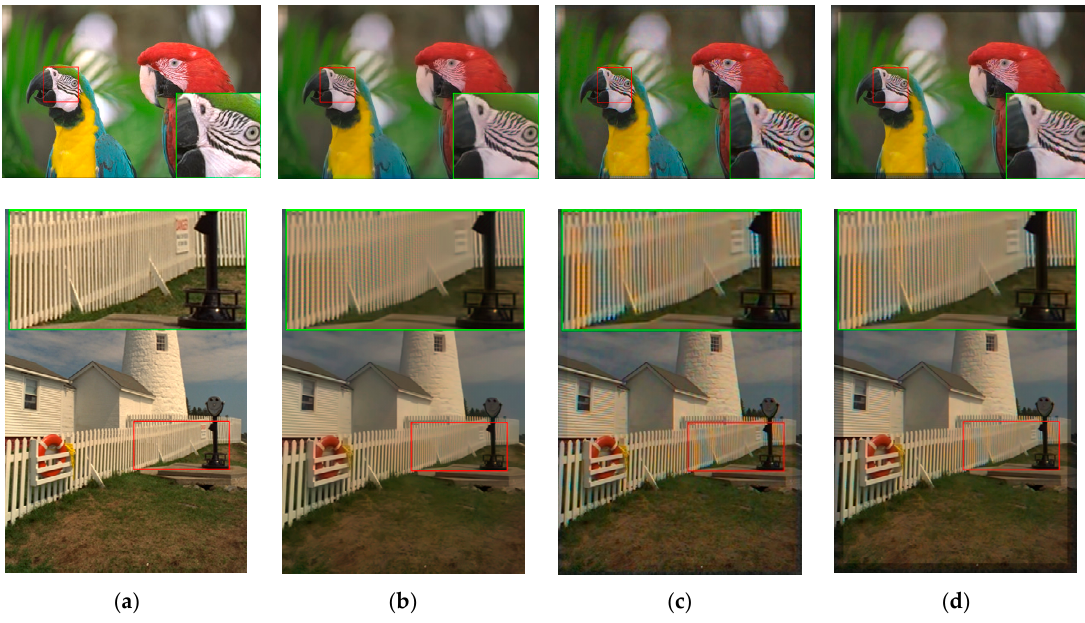
Figure 17. Visual comparison of three high performing demosaicing algorithms at 20 dBs SNR